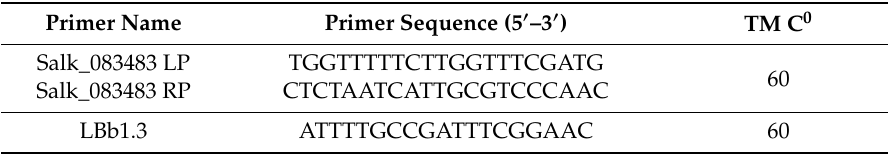
Table 3. Primers used for PCR for homozygous T-DNA insertion